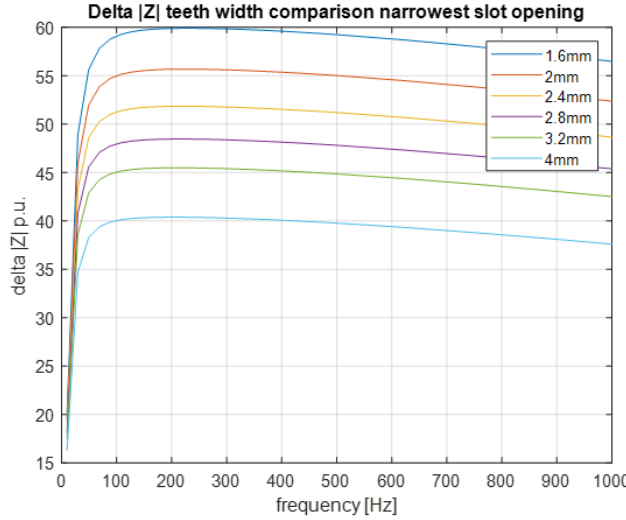
Figure 22. impedance comparison for different